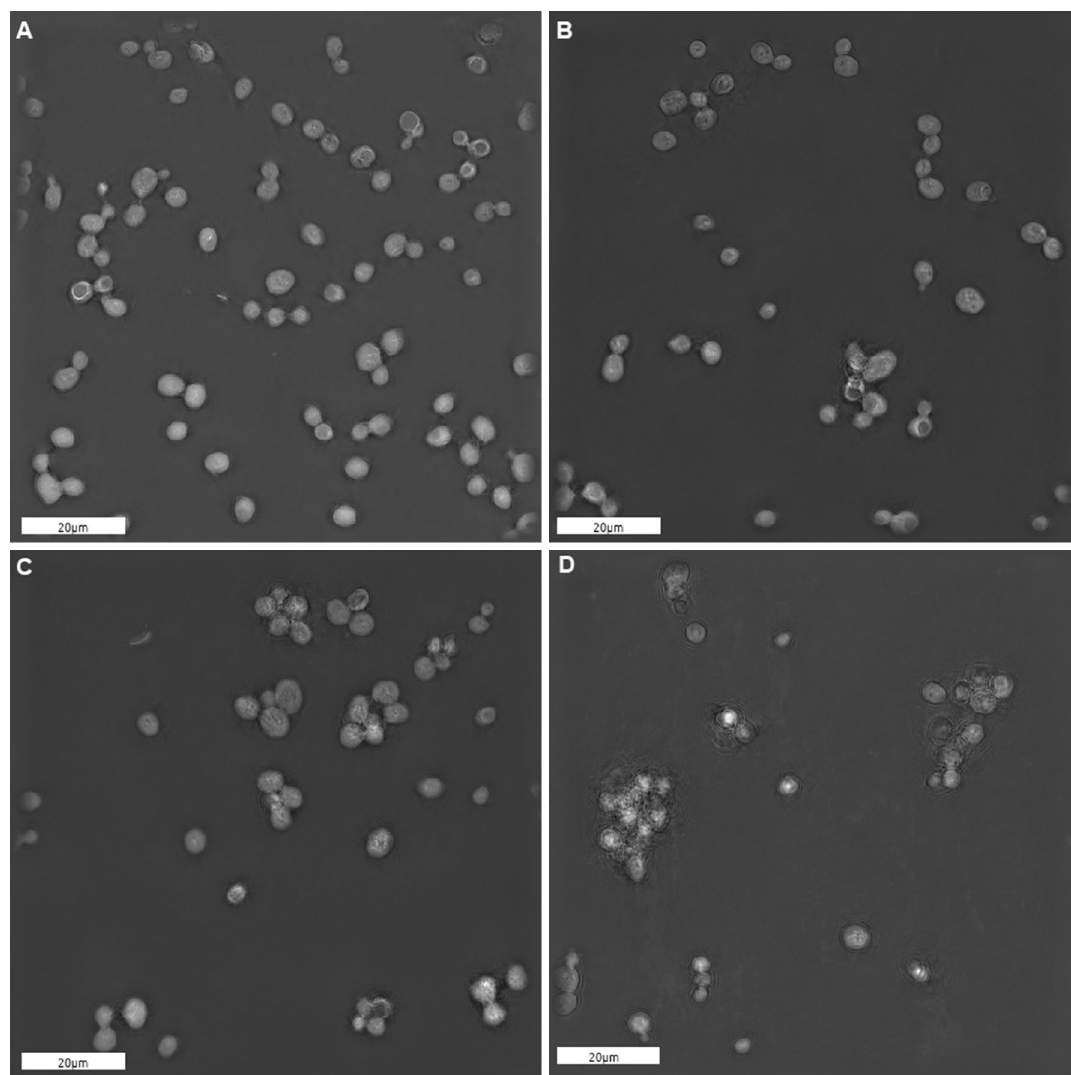
Figure 5. Microscopy of yeast cells after chemically induced oxidation treatment. Three different concentrations of hydrogen peroxide ( H 2 O 2 ) and fixed Fe 2 + concentration (0.5 mM) were applied. White bars are 20 µ m long. ( A ) Image of control (untreated) cell sample (0 mM H 2 O 2 ). ( B ) Image of oxidized cell sample (2.5 mM H 2 O 2 ). ( C Image of oxidized cell sample (25 mM H 2 O 2 ). ( D ) Image of oxidized cell sample (250 mM H 2 O 2